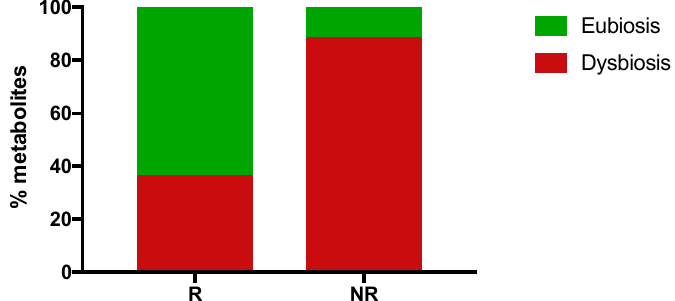
Figure 4. Percentage of eubiosis / dysbiosis gut metabolites in responding (R) and non-responding (NR) patients evaluated before the beginning of nivolumab treatment (T0). Gut metabolites were evaluated in the fecal samples of 11 NSCLC patients. Volatile organic compounds were analyzed by gas chromatography-mass spectrometry, while non-volatile metabolites were analyzed by proton nuclear magnetic resonance spectroscopy. In R patients, 14 metabolites were found, 9 related to eubiosis and 5 to dysbiosis. Non-responding patients (NR) showed 17 metabolites, 2 related to eubiosis and 15 to disbiosys. The histograms represent the percentage of eubiosis- (in green) and dysbiosis-(in red) associated gut metabolites evaluated, considering the 14 and 17 metabolites found in R and NR patients as 100%, respectively.